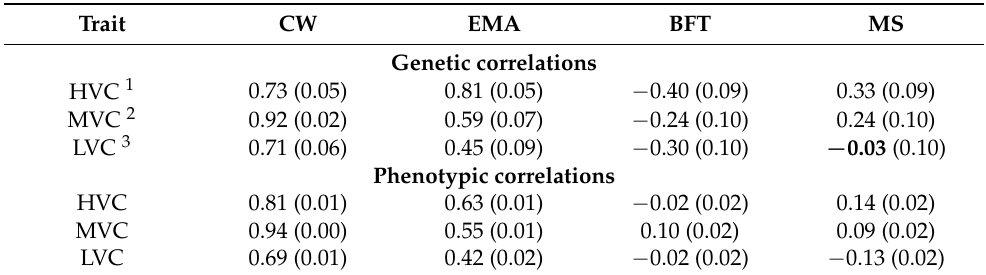
Table 5. Estimates of genetic and phenotypic correlations (SE in parentheses) between the composite primal cut traits and carcass traits in Hanwoo cattle.